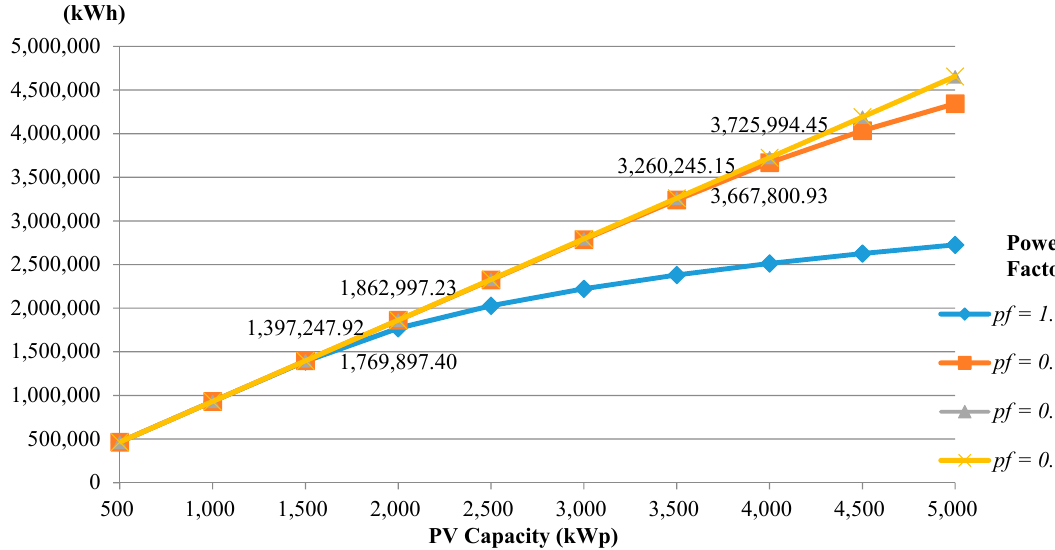
Figure 7. Annual PV real power injection for control abilities pf = 1.0, 0.95, 0.9, and 0.85.